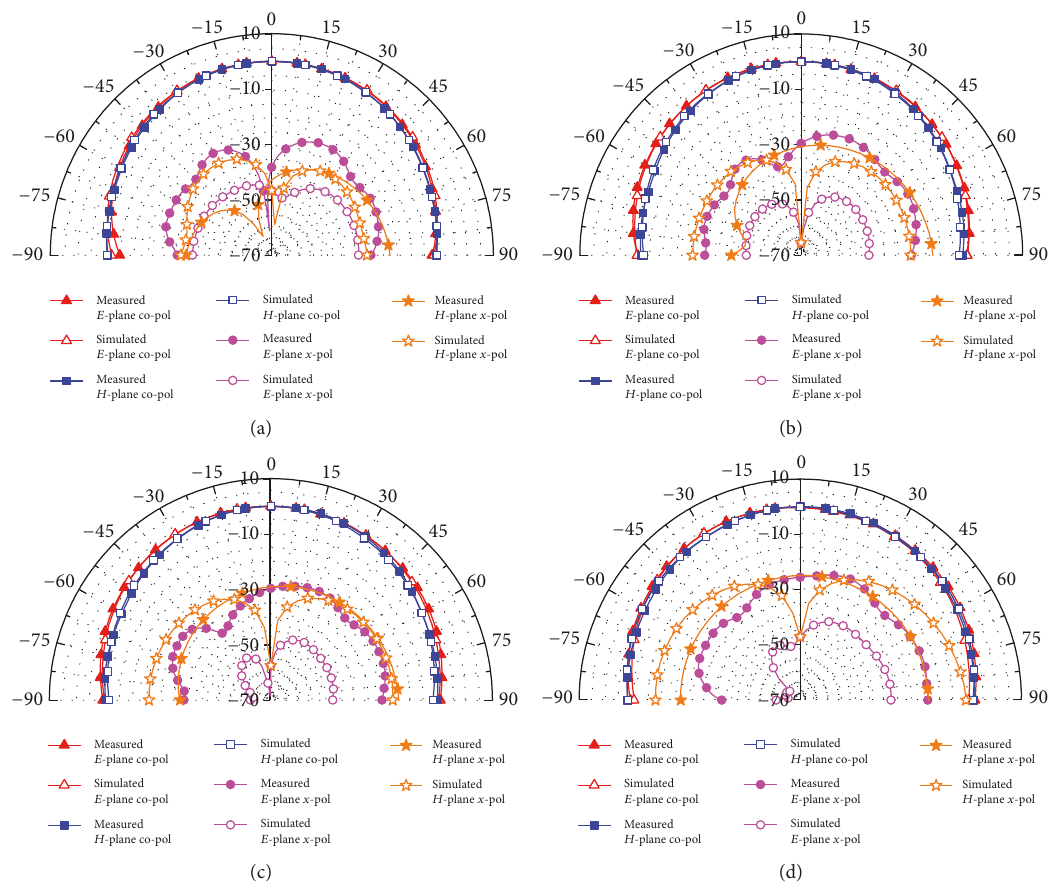
Figure 11: The simulated and measured normalized radiation patterns of the antenna in Figure 9(a) with 6 × 6 HIS array: (a) 0.55 GHz, (b) 0.60 GHz, (c) 0.65 GHz, and (d) 0.70